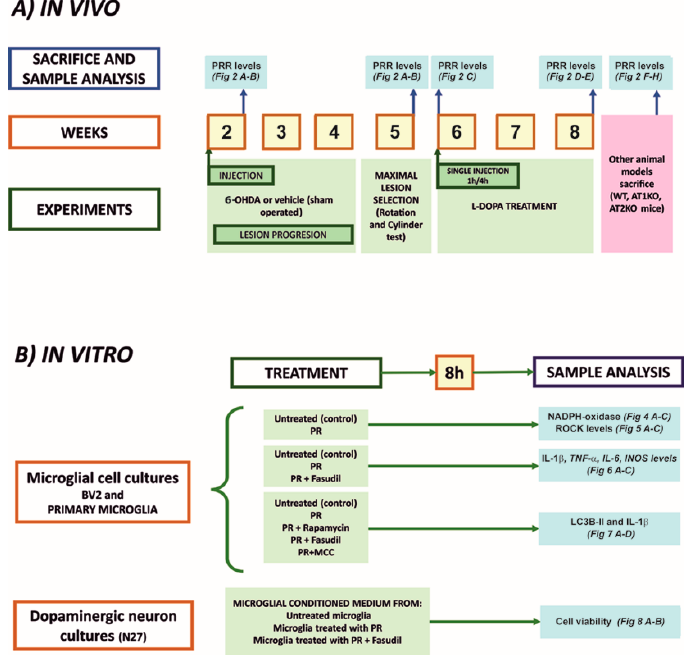
Figure 1. Time course of in vivo ( A ) and in vitro experiments using microglial cell cultures (BV2 and primary microglia) and N27 dopaminergic neuron cell line cultures ( B ). 6 ‐ OHDA, 6 ‐ hydroxydopamine; IL ‐ 1 β , interleukin1 β ; IL ‐ 6, interleukin 6; iNOS, inducible Nitric oxide synthases; LC3B, microtubule ‐ associated protein 1 light chain 3 beta; MCC, N ‐ [[(1,2,3,5,6,7 ‐ Hexahydro ‐ s ‐ indacen ‐ 4 ‐ yl)amino]carbonyl] ‐ 4 ‐ (1 ‐ hydroxy ‐ 1 ‐ methylethyl) ‐ 2 ‐ furansulfonamide; NADPH oxidase, nicotinamide adenine dinucleotide phosphate oxidase; PR, (pro)renin; PRR (pro)renin receptor.